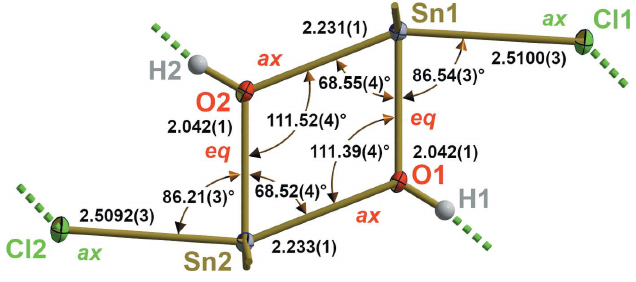
Figure 2 Ball-and-stick model of the inorganic framework of the [ t Bu 2 Sn(OH)Cl] 2 molecule highlighting selected bond lengths (A˚ ) and angles ( (cid:3) ). Positions of oxygen and chloride atoms within the trigonal–biypramidal coordina- tion of the tin atoms are labelled by use of the abbreviation ax (= axial ) and eq (= equatorial ). For clarity, t Bu groups are stripped down to the Sn—C bonds drawn as shortened sticks. Intermolecular O—H (cid:2)(cid:2)(cid:2) Cl hydrogen bonds are indicated by dashed sticks in green.